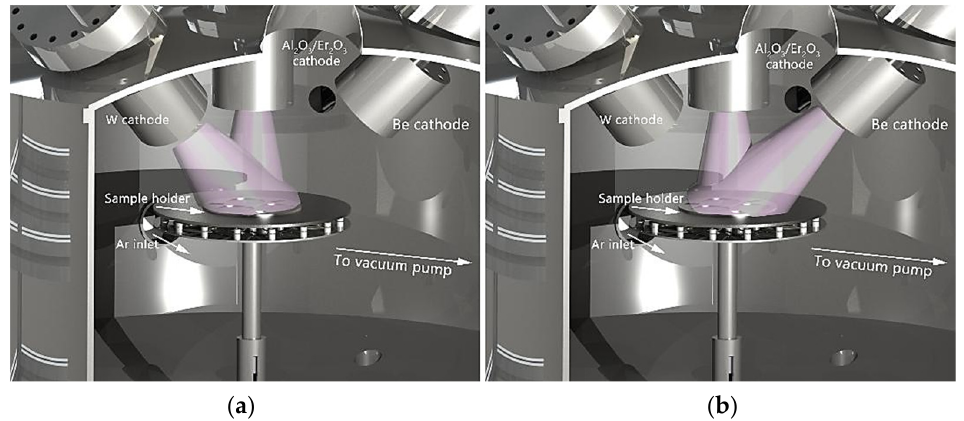
Figure 1. 3D rendering of co-deposition experimental setup where the positions of oxide and metallic targets can be observed; Overview on simultaneous plasma ignition of W ( a ) and Be ( b ) with oxides magnetrons. Table 1. Samples code name for each configuration and their representative deposition